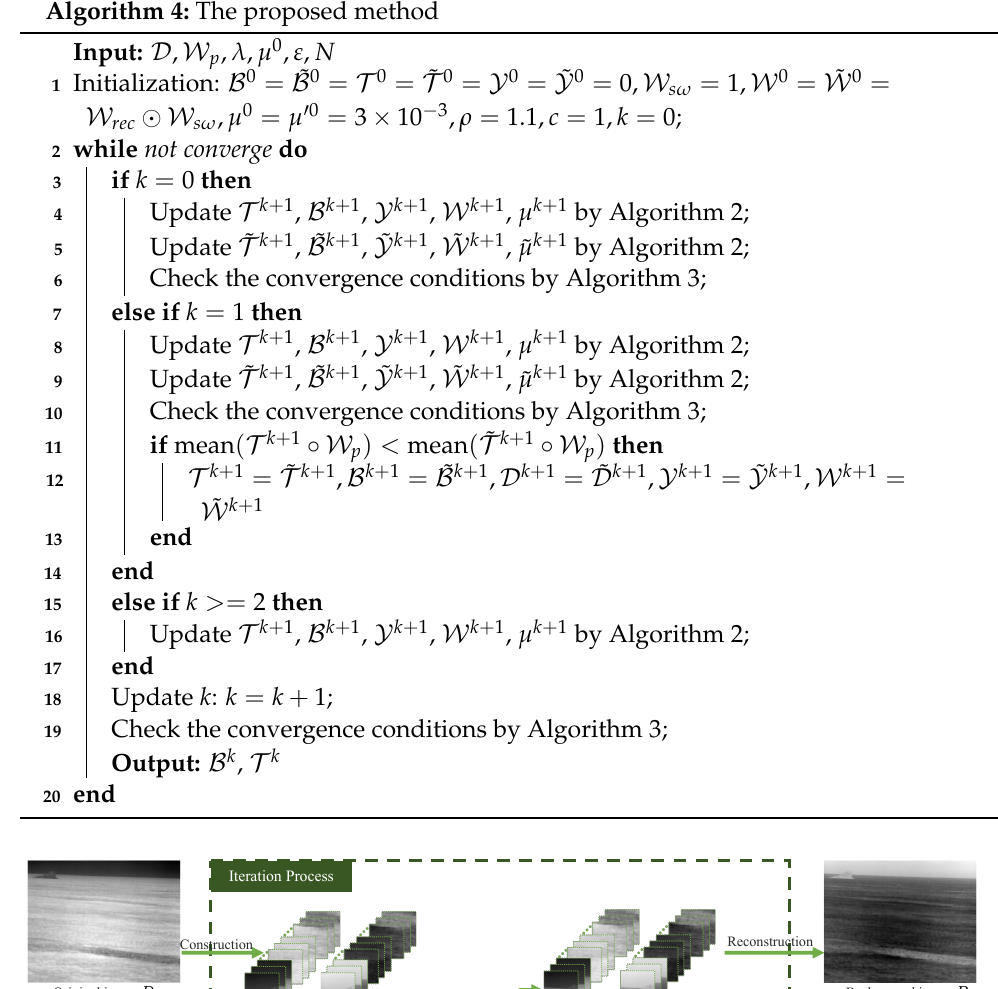
Algorithm 4: The proposed method